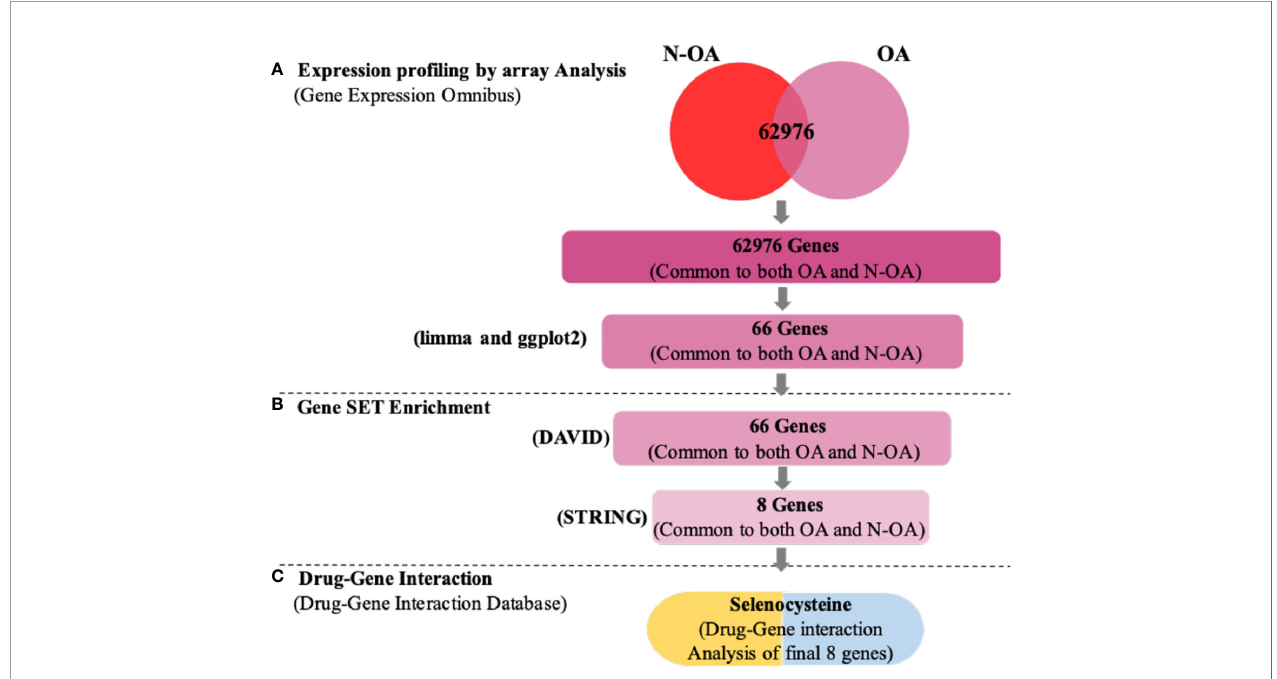
FIGURE 2 | Work fl ow of statistics mining. (A) Text mining: on the pursuit concepts osteoarthritis (OA) and patients without osteoarthritis (N-OA), text digging was accomplished with GEO, and 62,976 genes were established. (B) Gene enrichment: gene enrichment analysis was accomplished with GO and KEGG to enrich 66 genes. Meanwhile, by uploading Search Tool for the STRING, 66 hub genes were enriched, and among them eight signi fi cant genes were targetable by drugs using DGIdb. (C) Drug-gene interaction: these eight genes were established in DGIdb and the inhibitor Selenocysteine drugs were recognized as having a prospective impact on cartilage regeneration.